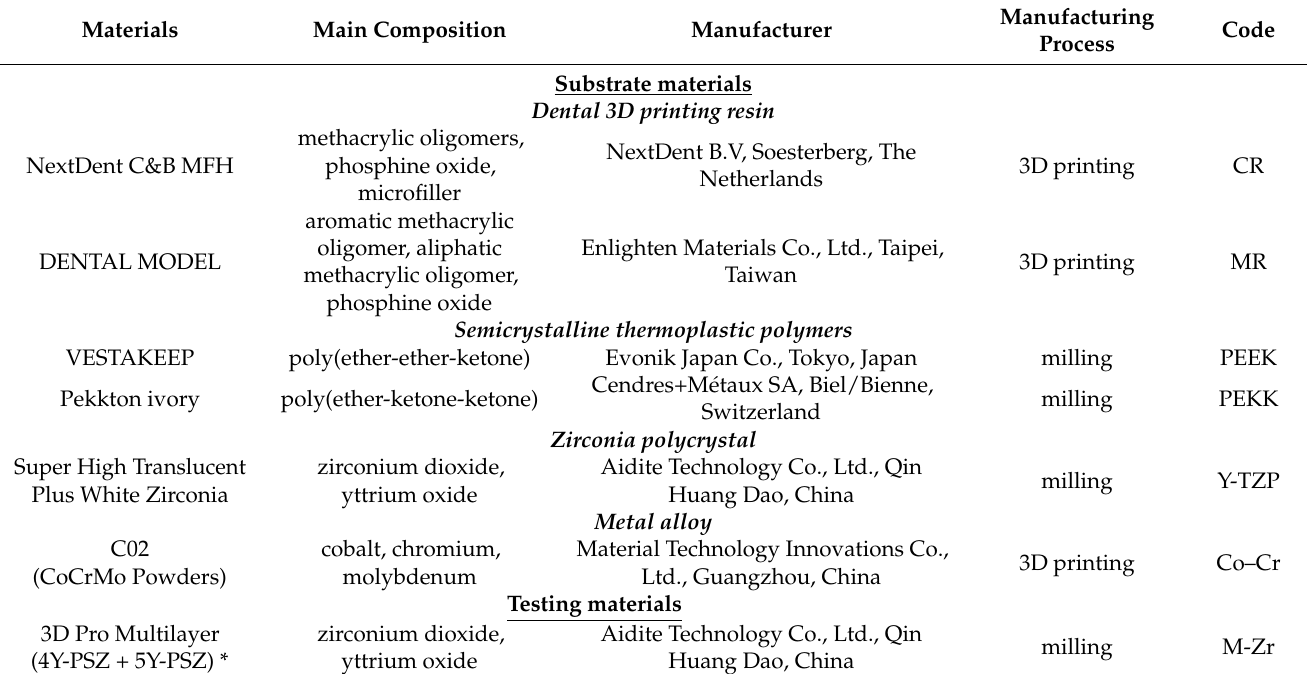
Table 1. Detail of the materials used. * 4Y-PSZ, 4 mol% yttria-partially stabilized zirconia; 5Y-PSZ, 5 mol% yttria-partially stabilized